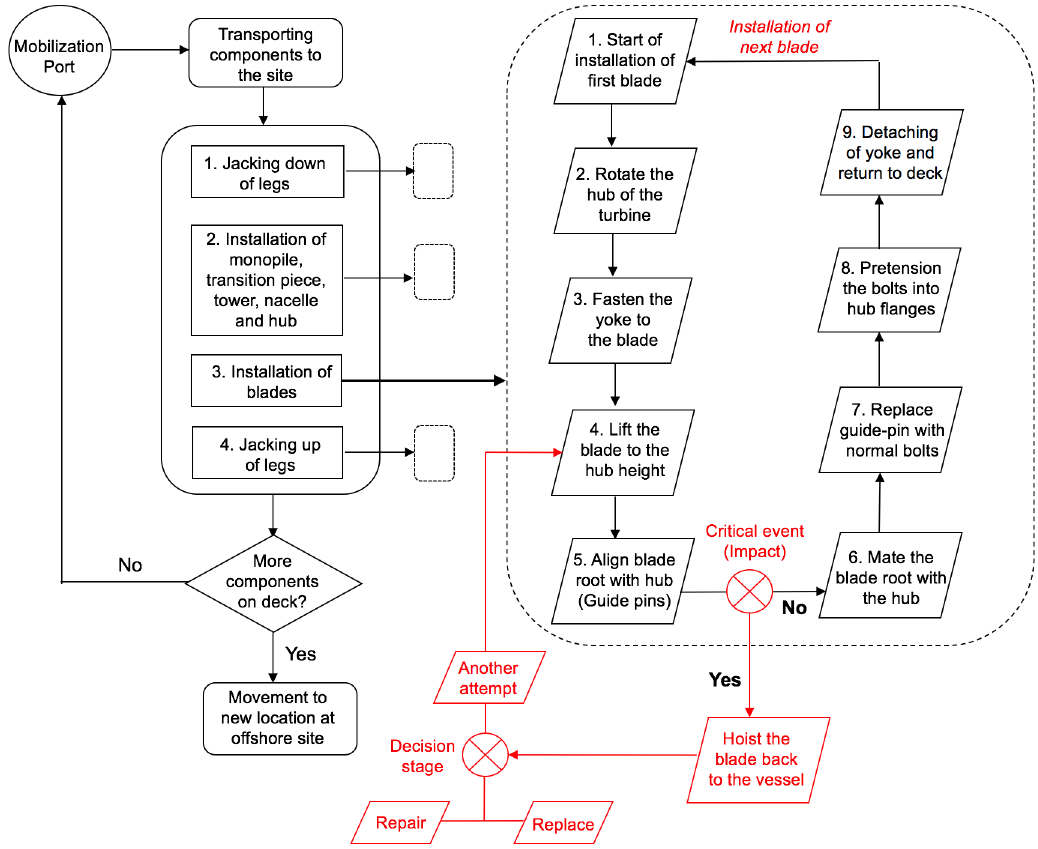
Figure 3. Detailed procedure involved during blade-root mating